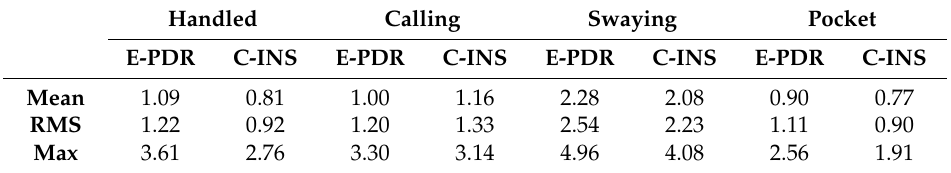
Figure 8. Trajectories of reference, E-PDR, and C-INS solutions for four different phone-holding positions. Table 2. Position errors of E-PDR and C-INS solutions for four different phone-holding positions (units of